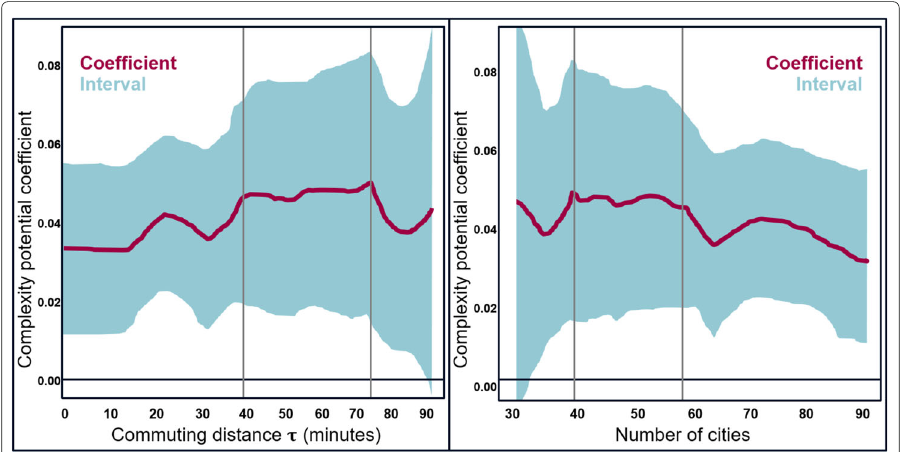
Fig. 9 On the left-hand panel, we show the coefficient of complexity potential, β 1 , allowing the set of cities to change as a function of commuting-time τ . The coefficient is shown in red, with the confidence intervals shown in blue. The right-hand panel considers how the coefficient varies with the number of distinct